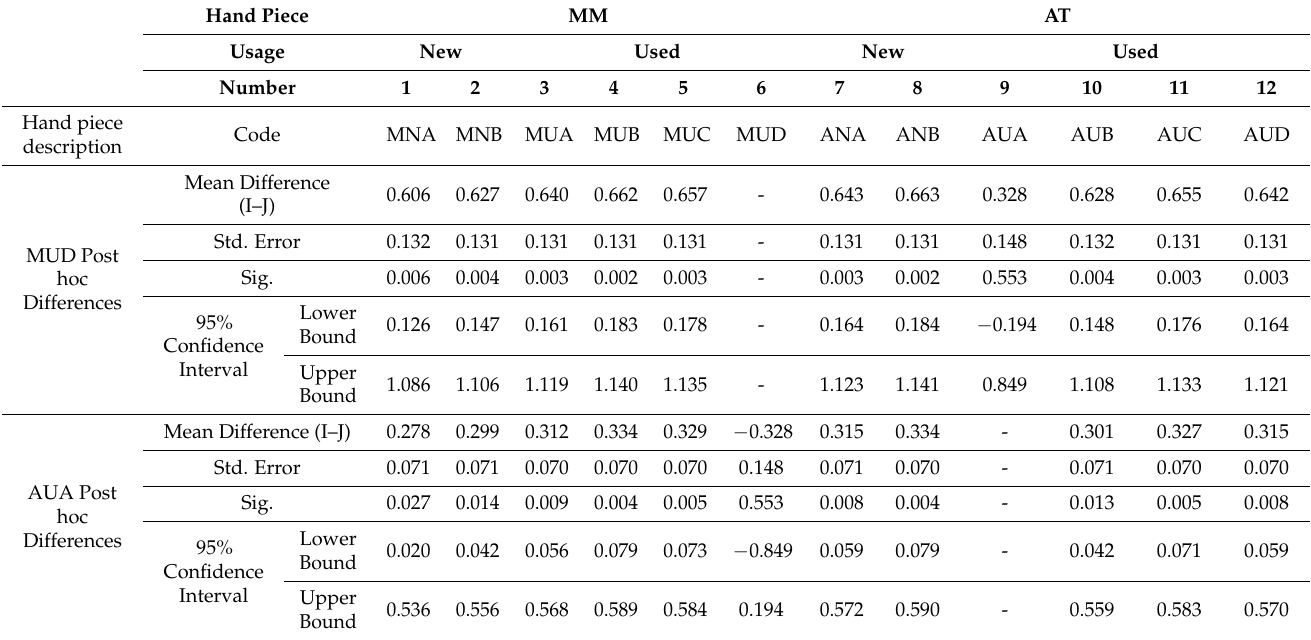
Table 3. Post hoc analysis for 1/3-octave band vibration amplitudes during